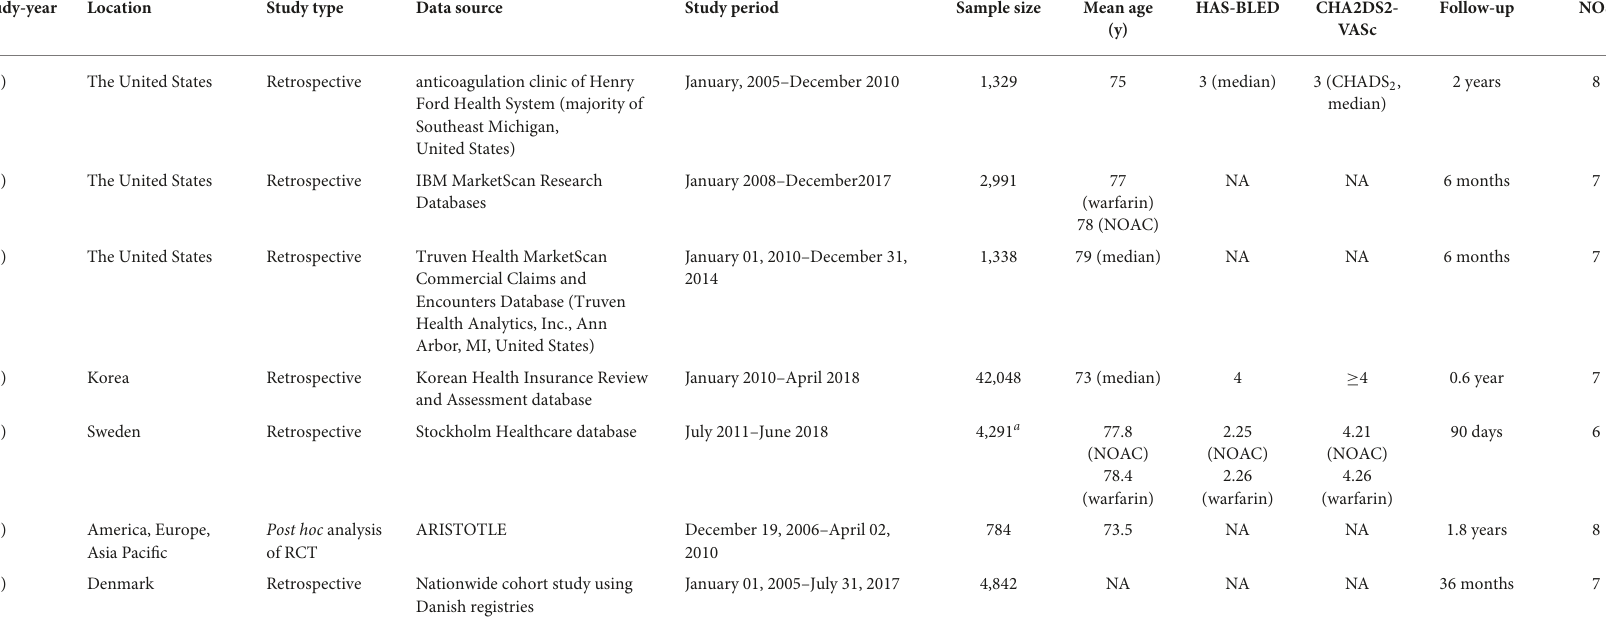
TABLE 1 General characteristics of the included studies in the